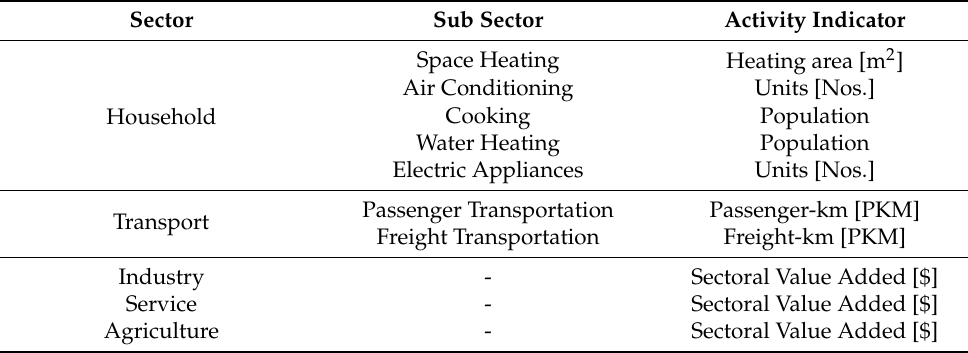
Table 3. Definition of the terms of activity in the bottom-up energy